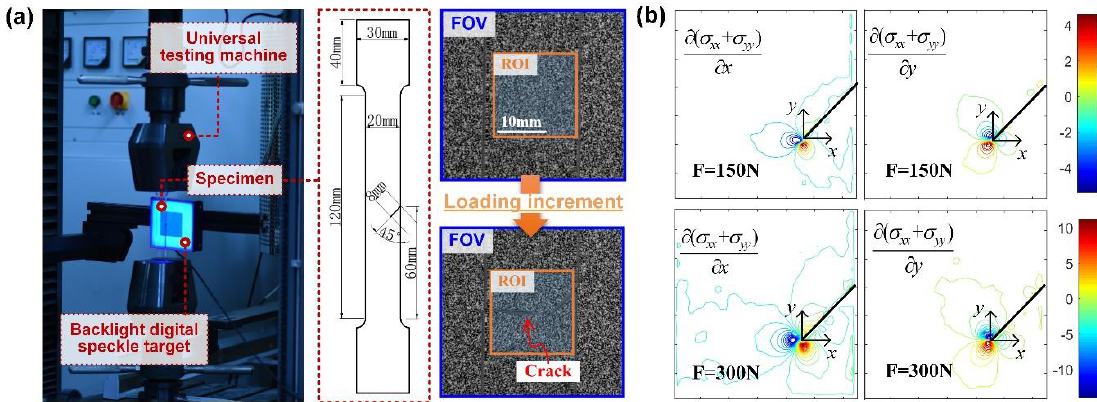
Figure 3. Experimental setups and captured images: ( a ) conventional speckle target; ( b ) backlight digital speckle target.